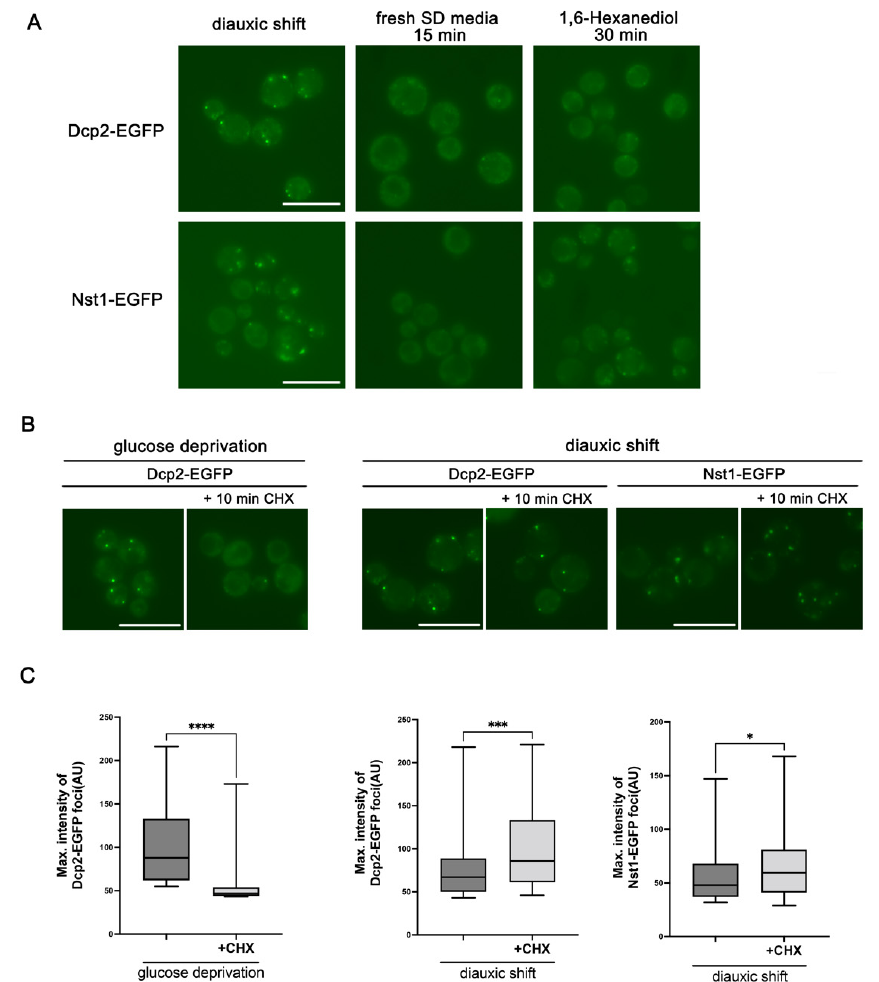
Figure 2. Nst1 condensates in diauxic phase cells are dispersed by 1,6-hexanediol but not rapidly disassembled by CHX, similar to Dcp2 condensates. Endogenous Nst1-EGFP (YSK3524) and Dcp2- EGFP (YSK3527)-expressing w303a cells were cultured up to a diauxic shift (OD 600 of 2–3) and ob- served using fluorescence microscopy. ( A ) Conversion of Nst1-EGFP and Dcp2-EGFP foci of diauxic shift cells was monitored after these cells were transferred to a fresh SD medium for 15 min or to a medium containing 10% 1,6-hexanediol for 30 min. Scale bar, 10 μ m. ( B ) The accumulation of Dcp2- EGFP and Nst1-EGFP condensates in cells on diauxic shift was examined before and after treatment with 100 μ g/mL CHX. For comparison, cells endogenously expressing Dcp2-EGFP in the exponen- tial growth phase were washed three times and incubated in a glucose-depleted medium for 10 min to induce glucose deprivation before being treated with 100 μ g/mL CHX for 10 min. Scale bar, 10 μ m. ( C ) Quantification of Nst1 and Dcp2 condensate accumulation in ( B ). The foci of Dcp2-EGFP and Nst1-EGFP were segmented, and the maximum pixel intensity values of Nst1-EGFP and Dcp2- EGFP foci were measured and analyzed using FIJI ImageJ. The methods for the segmentation and quantification of condensates are described in detail in the Section 4. Condensates in more than 60 cells under each condition were analyzed. Error bars show mean ± standard error of the mean (SEM). Statistical significance was determined using Student’s t test (* p < 0.05, *** p < 0.001, **** p < 0.0001). As stress-induced PB accumulation is reduced when CHX is treated, the polysome- free RNA is recognized as an indispensable factor in the stressed-induced PB condensa- tion of exponentially growing cells [28]. Thus, we examined whether PB accumulation in cells at the diauxic shift is affected by the decrease in polysome-free RNA levels in the